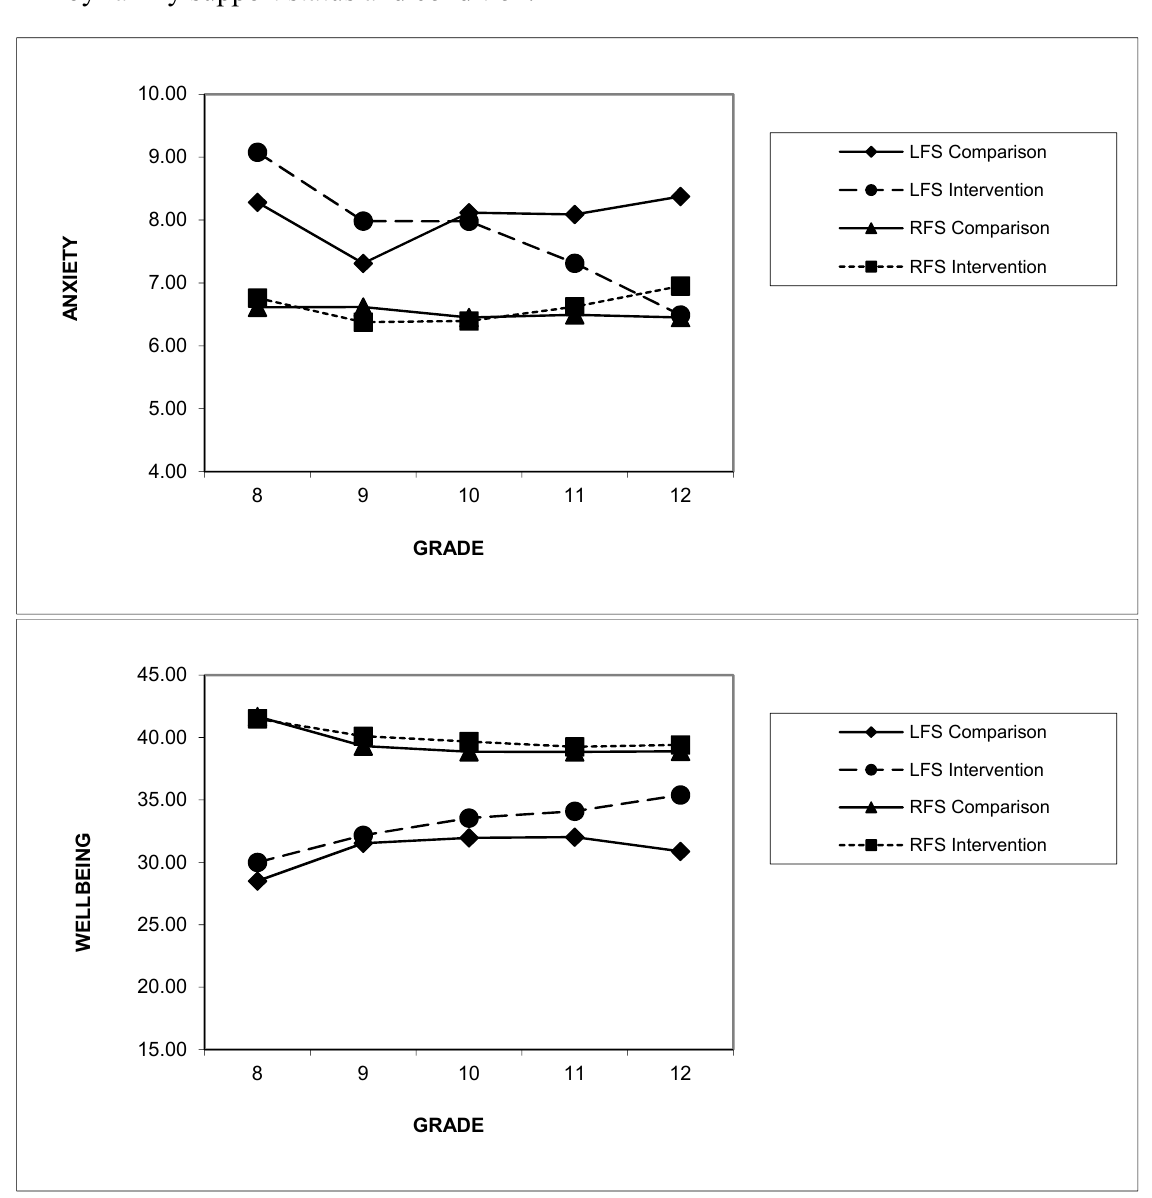
Figure 3. Estimated means for anxiety and emotional wellbeing scores from Grades 8 to 12 by family support status and